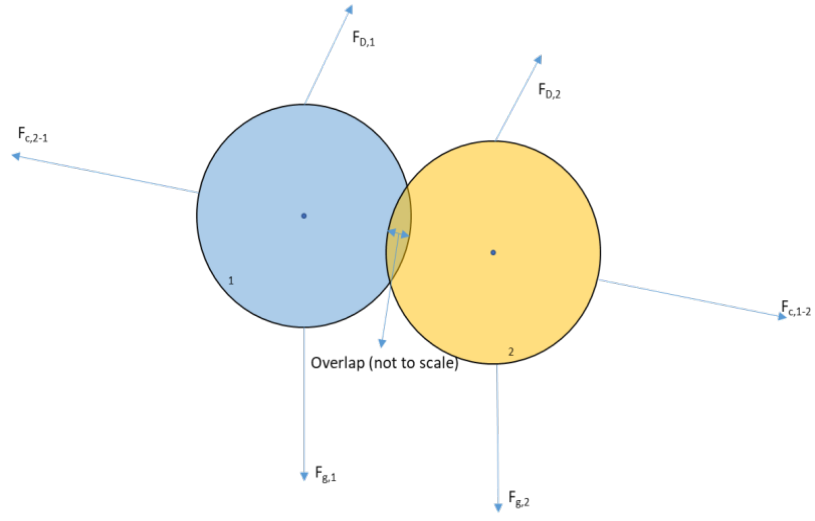
Figure 6. Main forces acting on two colliding particles in the soft sphere approach.